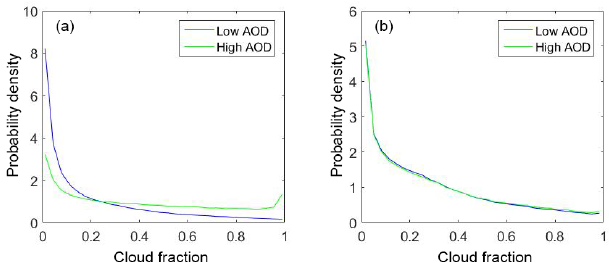
Figure 2. An example of the probability density distribution of warm cloud fraction (CF) for low- and high-AOD conditions. (a) There is a strong link between AOD and CF before histogram normalization; (b) the link is reduced after histogram